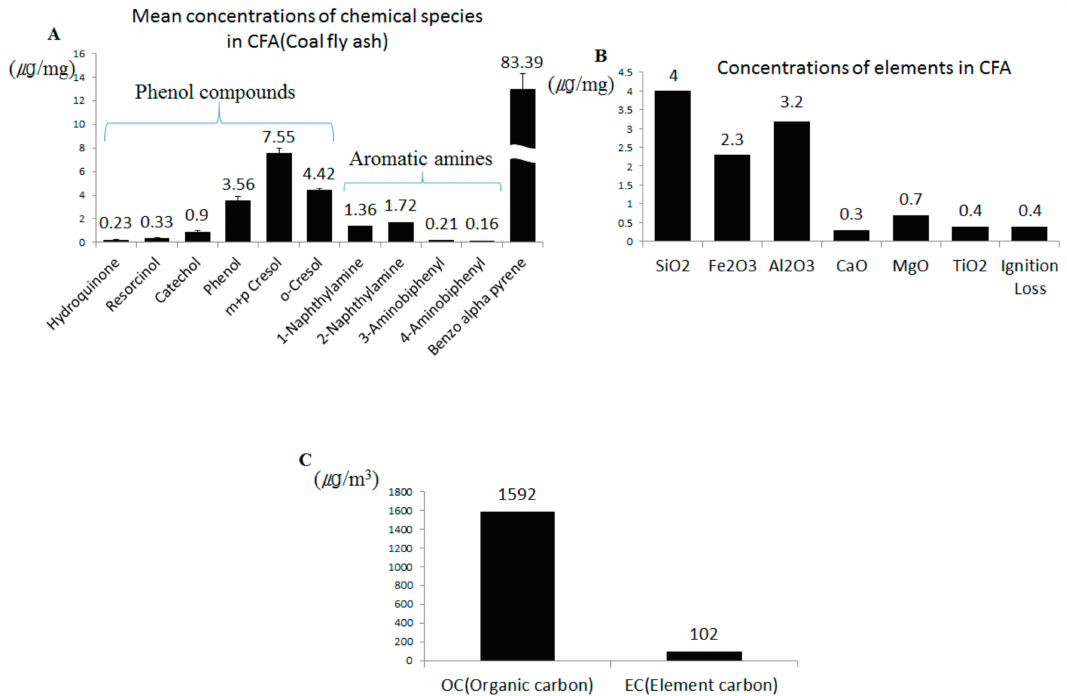
Figure 1. Constituents of polycyclic aromatic hydrocarbons (PAHs) content in coal fly ash (CFA) combustion particles ( A ). Chemical composition and mean concentrations of chemical species of CFA ( B ). Composition of OC (organic carbon), EC (element carbon) in CFA sample ( C